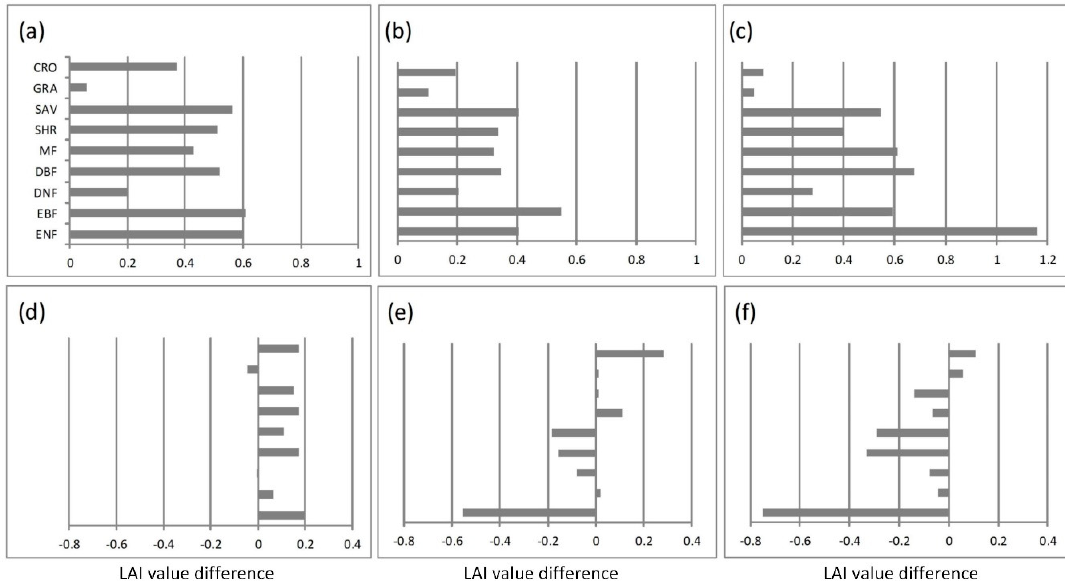
Figure 12. LAI value difference between LAI climatologies for each biome type: ( a ) GLASS-MODIS; ( b ) GLOBALBNU-MODIS; ( c ) GLOBMAP-MODIS; ( d ) GLASS-GLOBALBNU; ( e ) GLASS-GLOBMAP; ( f ) GLOBALBNU-GLOBMAP. ENF represents evergreen needleleaf forest, EBF represents evergreen broadleaf forest, DNF represents deciduous needleleaf forest, DBF represents deciduous broadleaf forest, MF represents mixed forest, SHR represents shrubland, SAV represents savannas, GRA represents grassland, and CRO represents cropland).